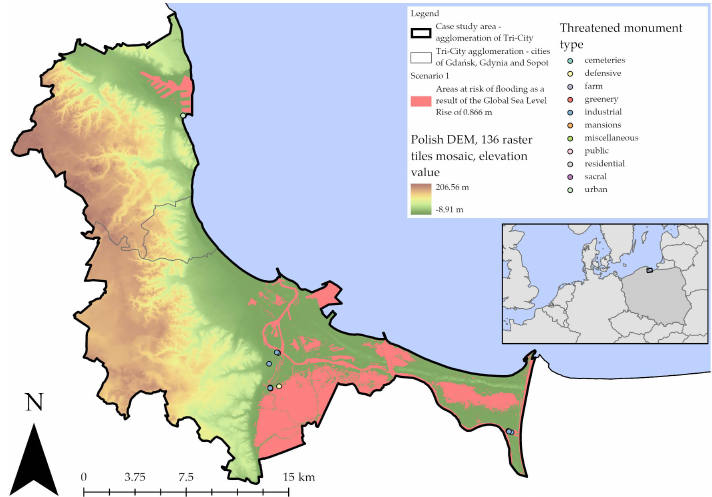
Figure 9. Global sea level rise scenario 1 for the case study area (the year 2100). Source: own elaboration using ArcGIS Pro 2.7, on the basis of the data from Polish